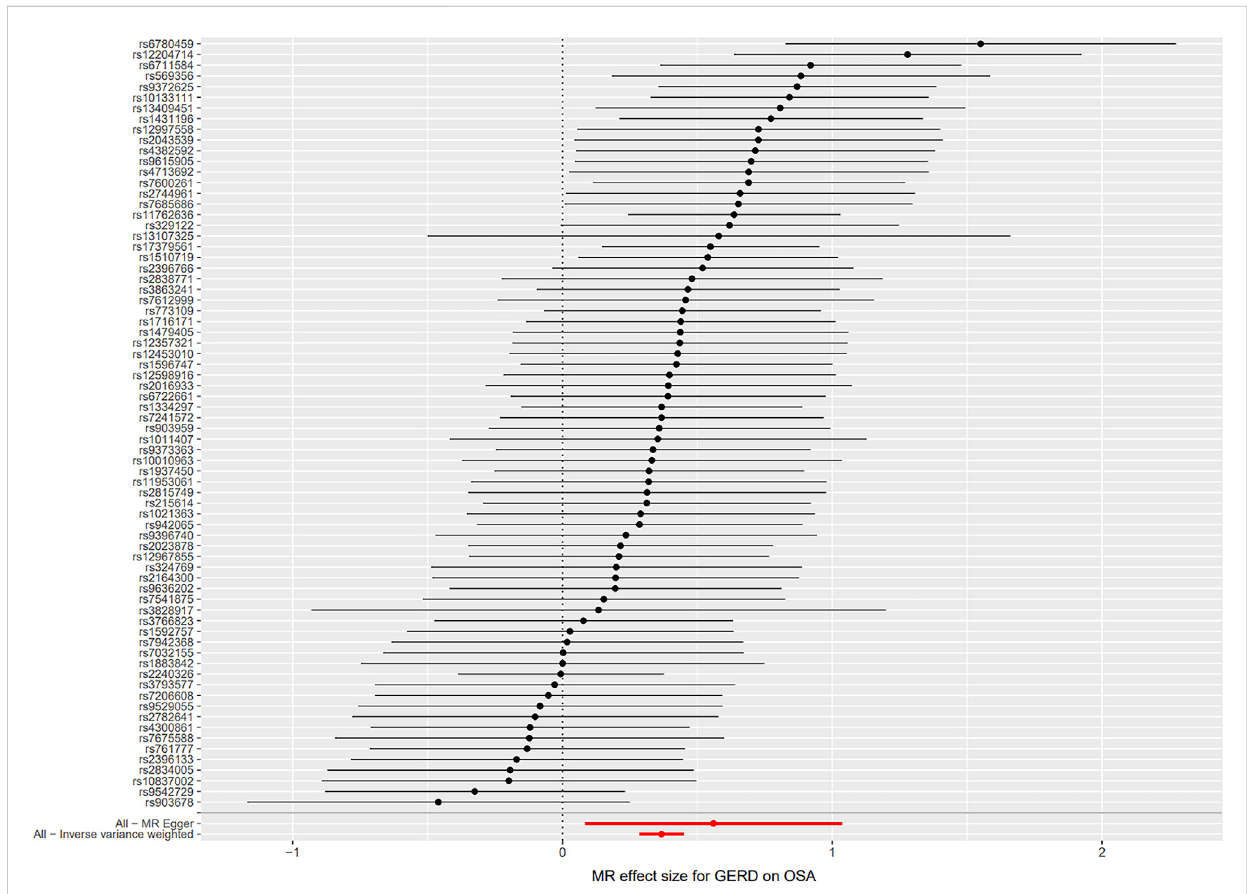
FIGURE 6 Forest plot for the causal relationship of GERD on OSA. Abbreviation: MR, Mendelian randomization; GERD, gastroesophageal re fl ux disease; OSA, obstructive sleep apnea.